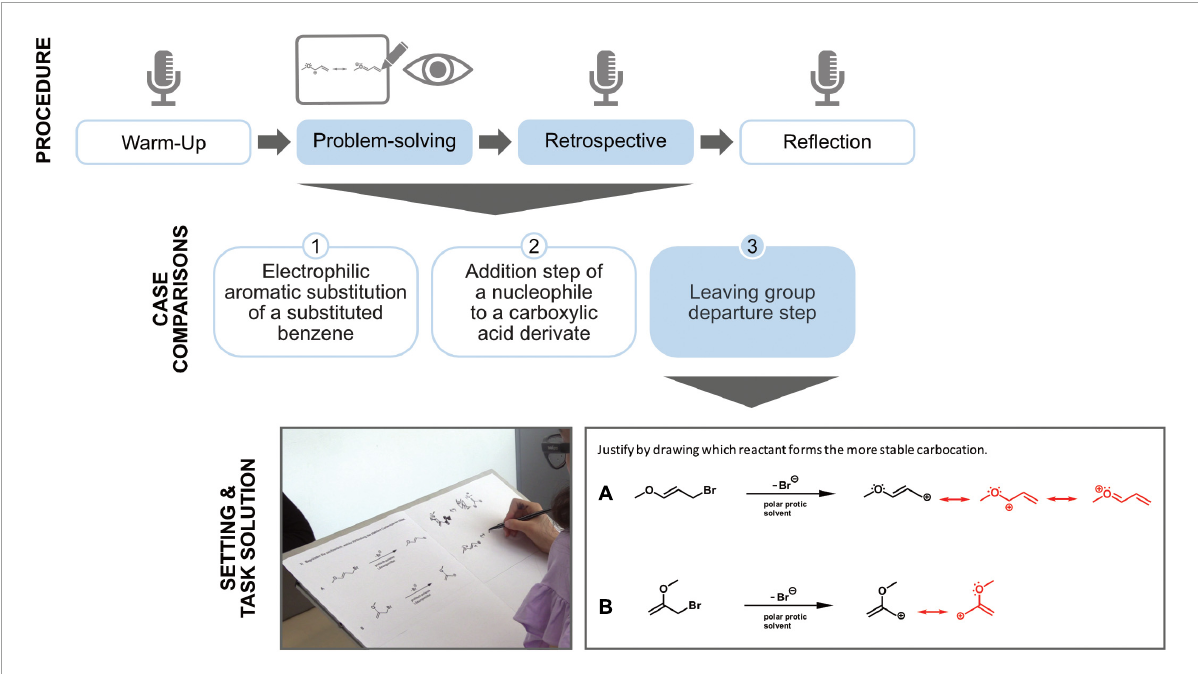
FIGURE1 Study design and task solution for the utilized case comparison. Blue boxes indicate the results highlighted in this